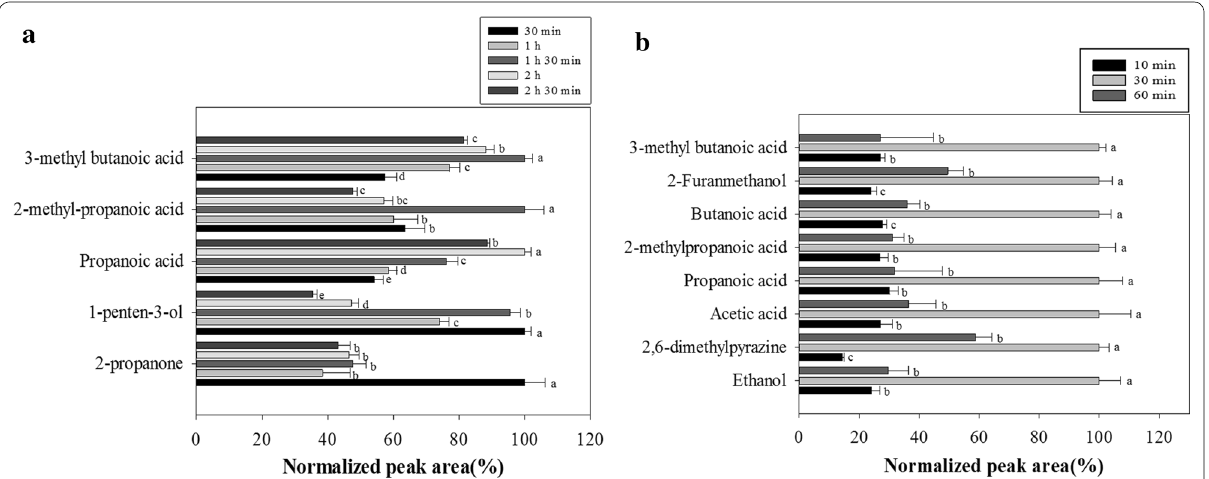
Fig. 2 Effect of extraction time using different a SPME and b SPME‑Arrow methods for the extraction of volatile compounds in fish sauce ( p <